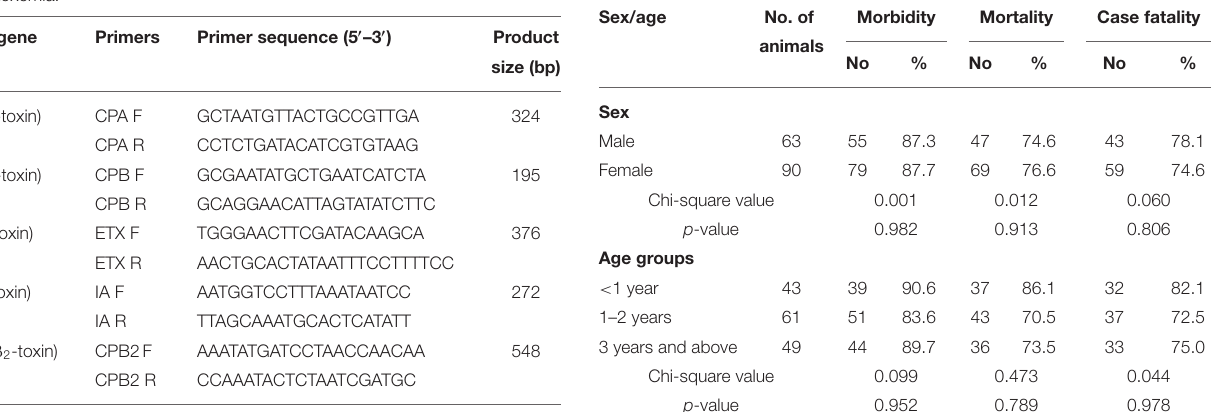
TABLE 1 | Primers used for multiplex polymerase chain reaction (PCR) for the detection of different toxins from fecal material collected from goats that died of enterotoxemia.